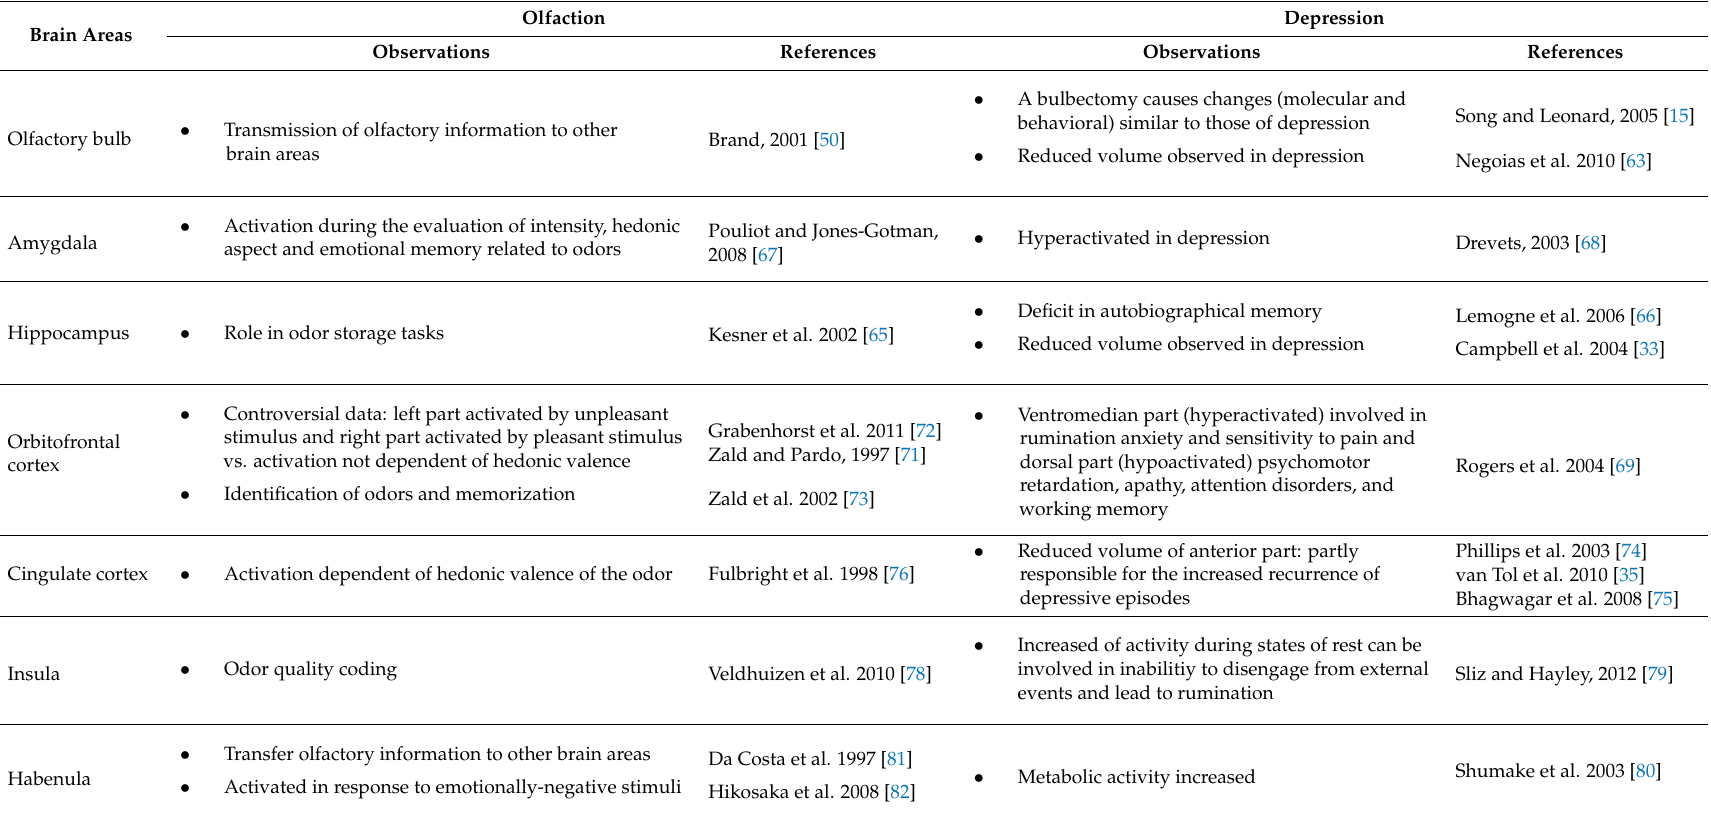
Table 1. Brain areas involved in the processing of olfaction and